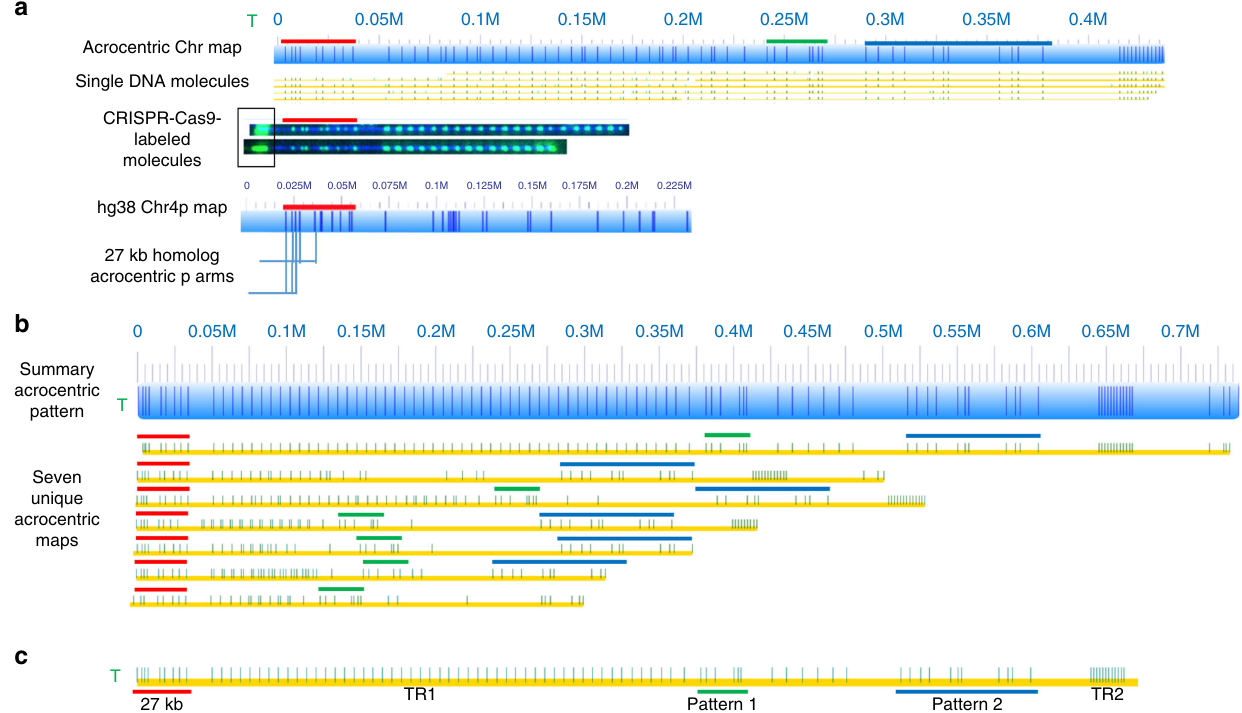
Fig. 7 Acrocentric chromosome patterns in non-aligned maps. Non-aligned maps were grouped into unique patterns. These groups were analyzed for patterns localizing maps to near telomeric regions. a An acrocentric map (blue) supported by molecules (yellow) with Nt.BspQI labels (green dots) aligned to an in silico labeled map (dark blue vertical lines). Molecules comprising the maps were localized to acrocentric regions by a CRISPR-Cas9 labeling method described previously. The green T indicates telomere labeling. The 27-kb homolog, shown by the blue teeth underneath the chromosome 4p map, was identi fi ed by in silico nicking of the chromosome 4p sequence indicated by red bars throughout the fi gure. b Seven unique acrocentric maps (yellow bars with green BspQI labels) were identi fi ed and aligned to a summarized version (blue bar). The red-, green-, and blue-colored bars indicate the elements de fi ning an acrocentric map. c A general model for an expected acrocentric map. From the telomeric end (green T), the 27-kb homolog must be present (red bar), followed by tandem repeat region 1 (TR1), a unique labeling pattern (green bar, Pattern 1), a second unique labeling pattern (blue bar, Pattern 2), and a fi nal tandem repeat region (TR2). Patterns 1 and 2 exhibit little variation, while unit counts of the tandem repeat regions varied